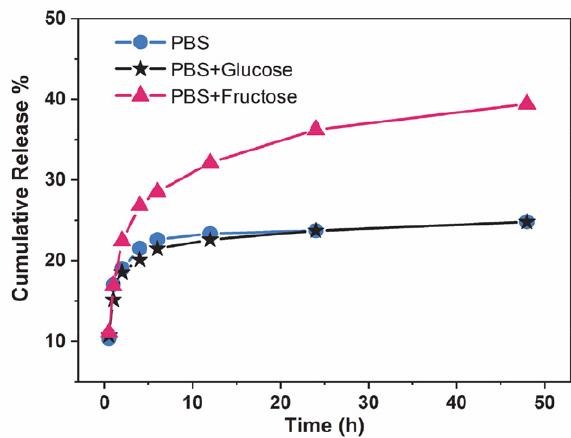
Figure 7. Time dependent Rhodamine B dye release % of P-P-3 sample dispersed in different